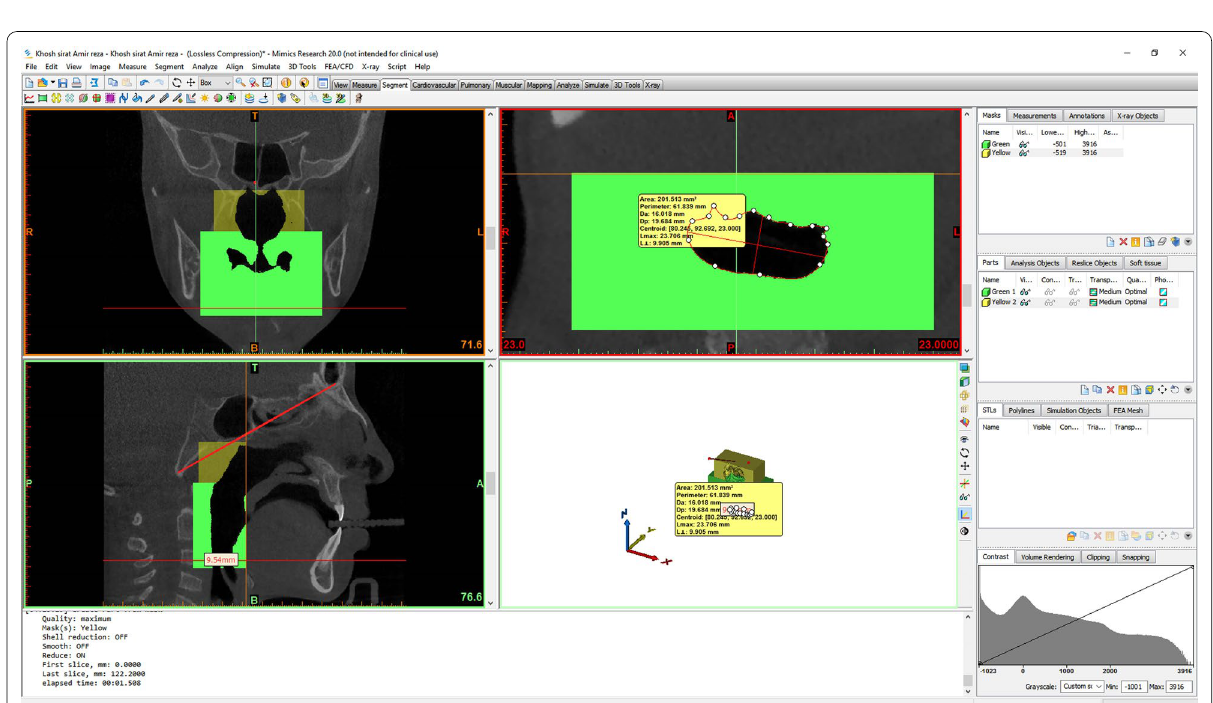
Fig. 2 Measuring the airway cross-sectional area on axial